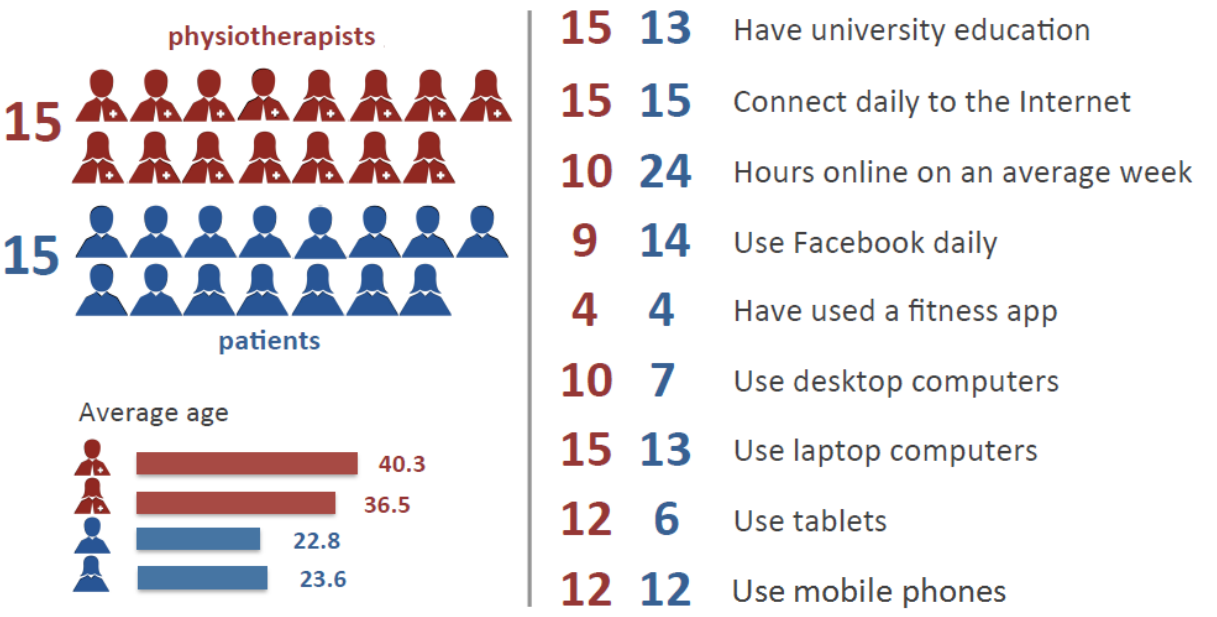
Figure 7. A summary of responses about computer and Internet